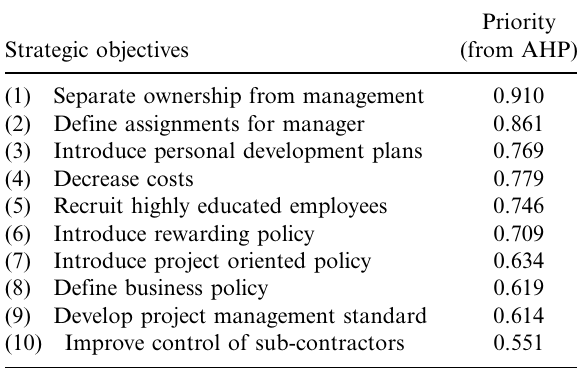
Table 5. Pair-wise weights for the AHP model for selecting strategic objectives Strategic